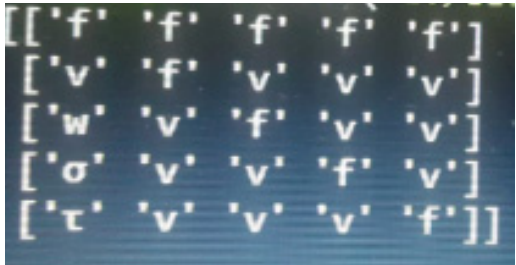
Figure 2. Composition 𝑥𝜊𝑦 , for any 𝑥, 𝑦 of a universal set of medications. This algorithm makes the members distributive for any set η = { r 1 , r 2 , . . . , r n } that has n members inside a matrix M = table can have the structure of δ -algebra. Therefore, the binary operation is described in a Table